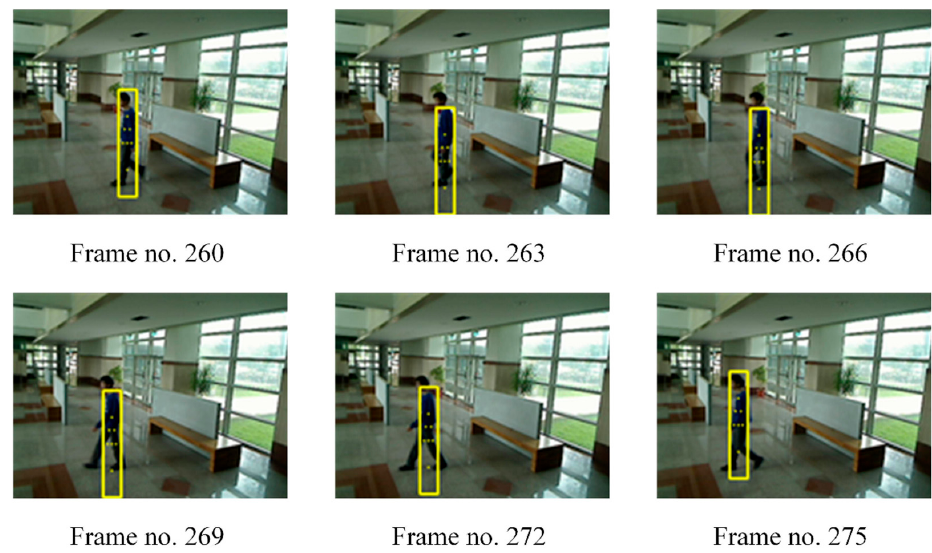
Figure 12. Frame no. 260~275 from Cam3 in single person tracking scene.